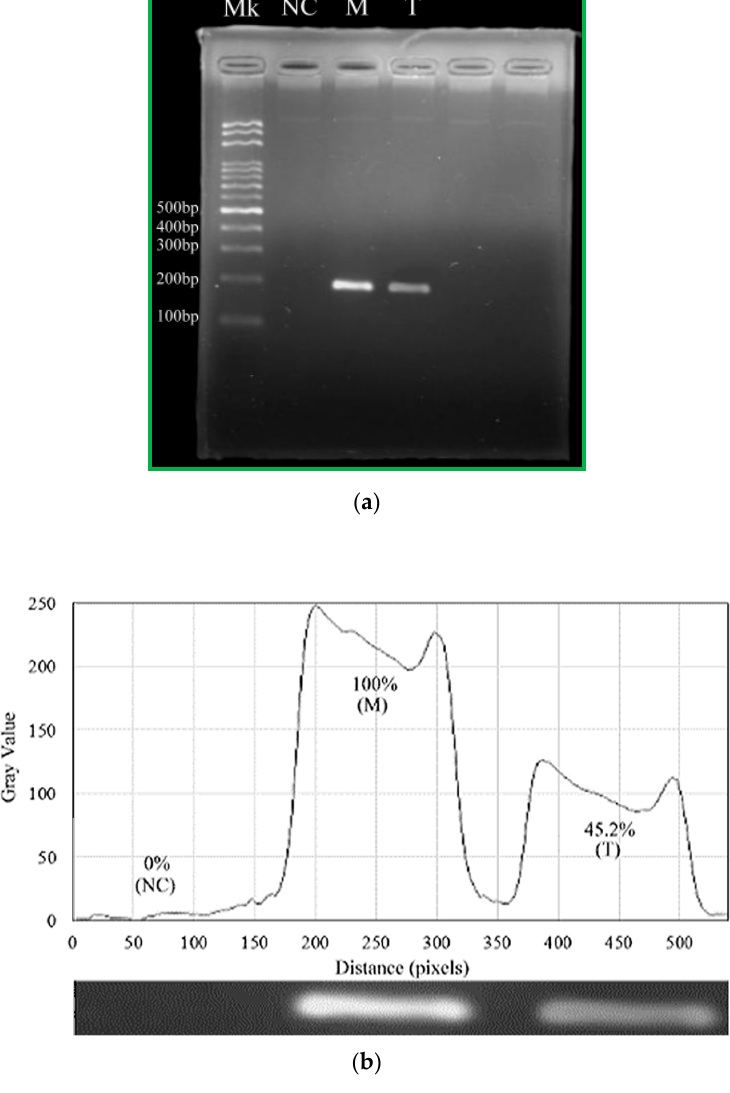
Figure 11. ( a ) The results of gel electrophoresis analysis of the products. The first lane (Lane Mk) indicates the DNA ladder. The second lane (Lane NC) indicates the negative control inside a conventional PCR machine. The 200 bp PCR product in the commercial PCR machine and CFPCR chip (Lanes M and T). ( b ) The grey intensities of PCR products by image